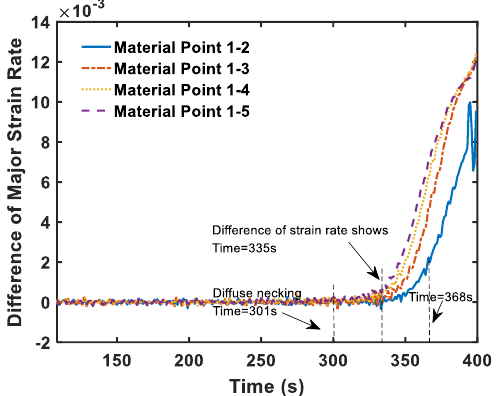
Figure 6. The difference in major strain rate of high-strength steel.